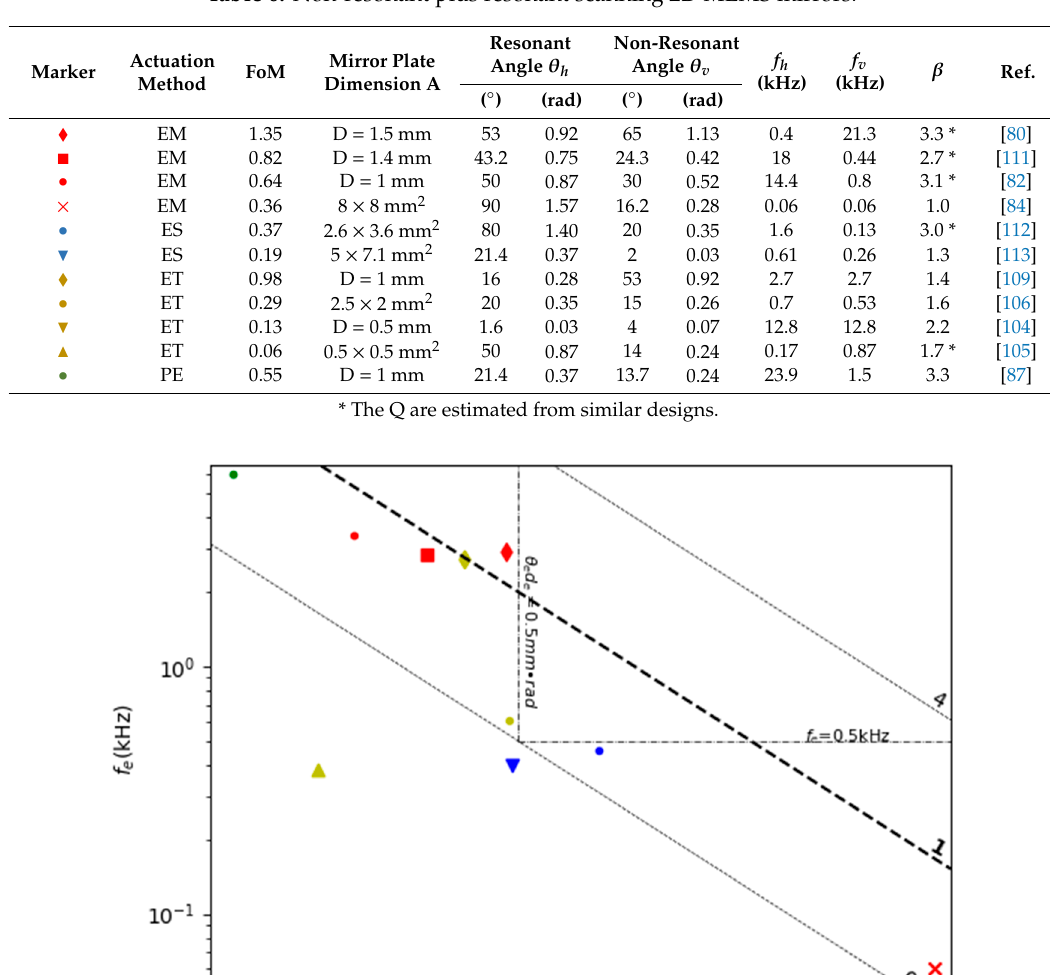
Figure 15. High-FoM 2D quasi-static and resonant scanning MEMS mirrors with ( a ) electromagnetic actuators [80]; ( b ) electrothermal actuators [109]; ( c ) electrostatic actuators [112]; ( d ) piezoelectric actuators [87].